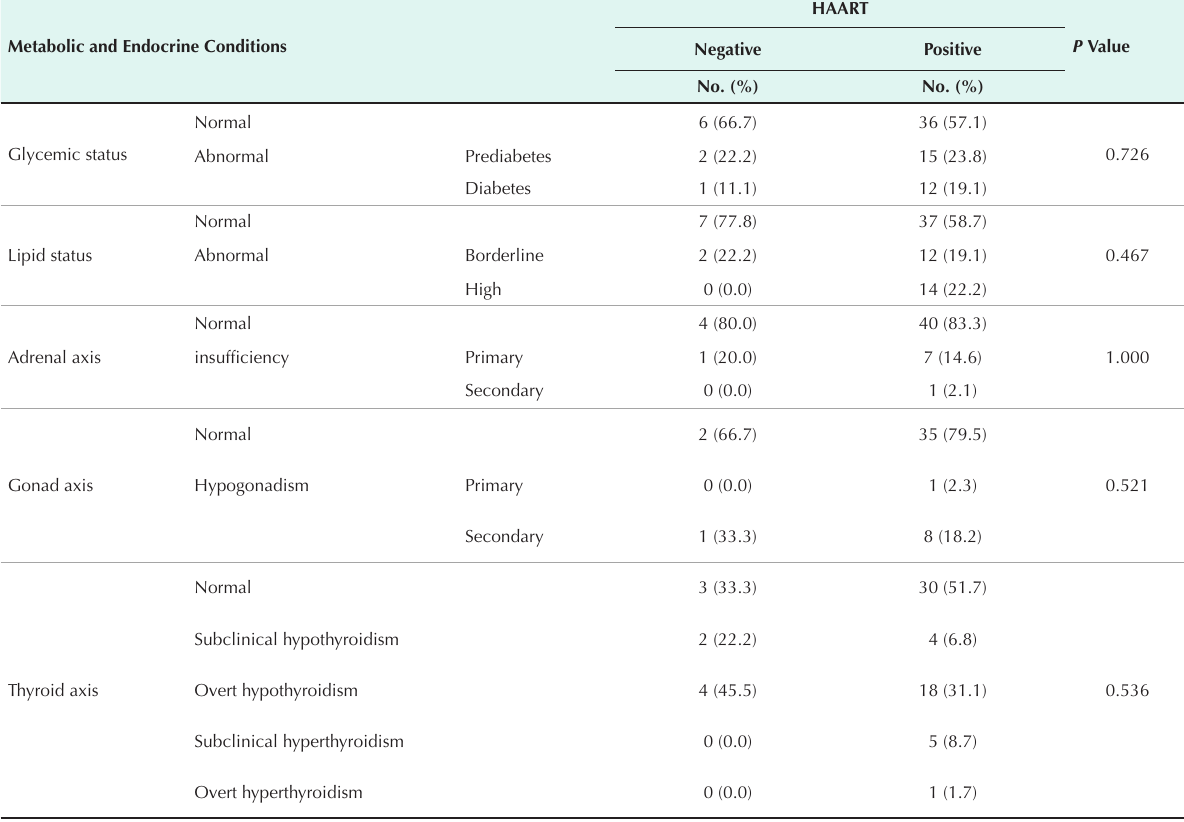
Table 6. Metabolic and Endocrine Disorders by HAART in 72 HIV-positive Patients